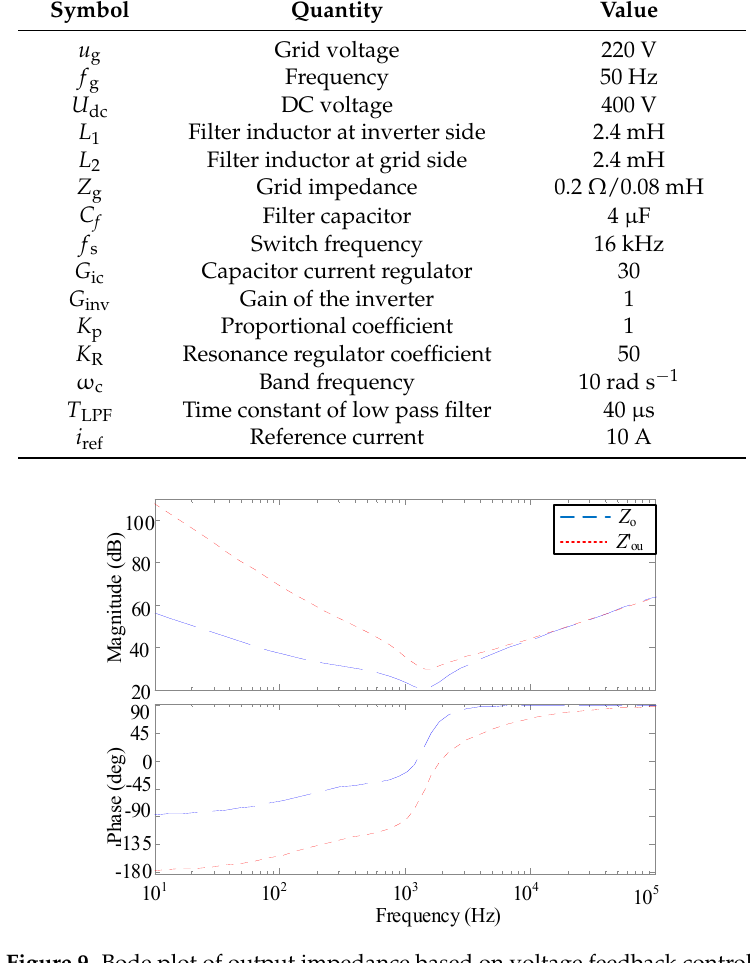
Figure 9. Bode plot of output impedance based on voltage feedback control.